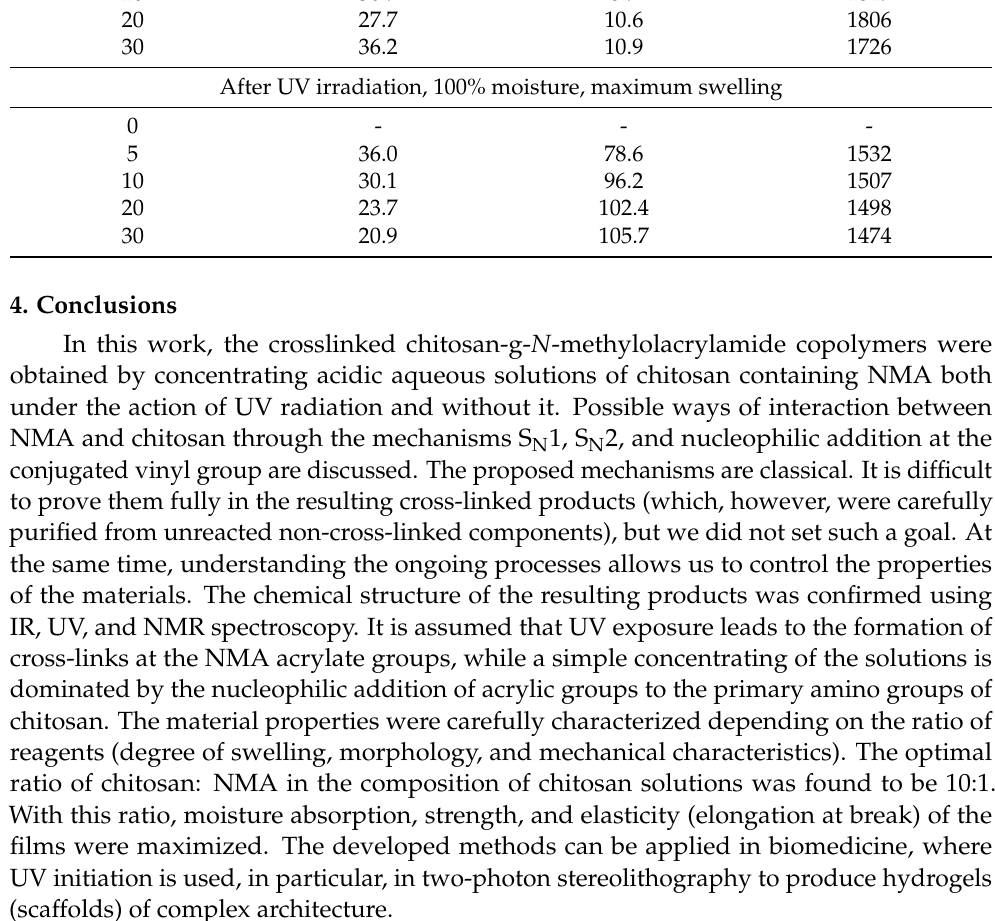
NMA. Figure S4: S N 2 mechanism of the interaction between chitosan and NMA. Figure S5: Proposed scheme of nucleophilic addition